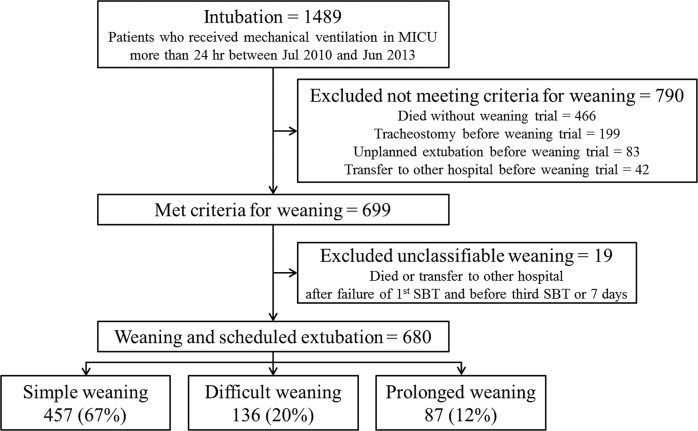
Flow chart of inclusion and exclusion criteria.MICU, medical intensive care unit; SBT, spontaneous breathing trial.